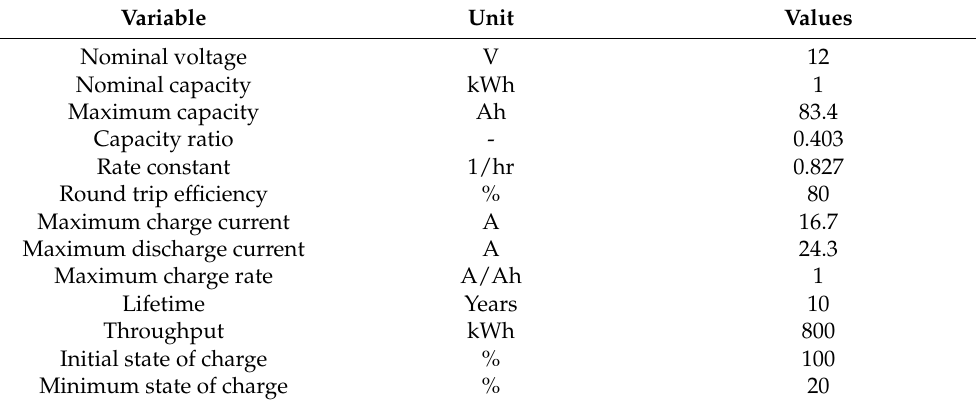
Table 4. Properties and the variables of the battery system.